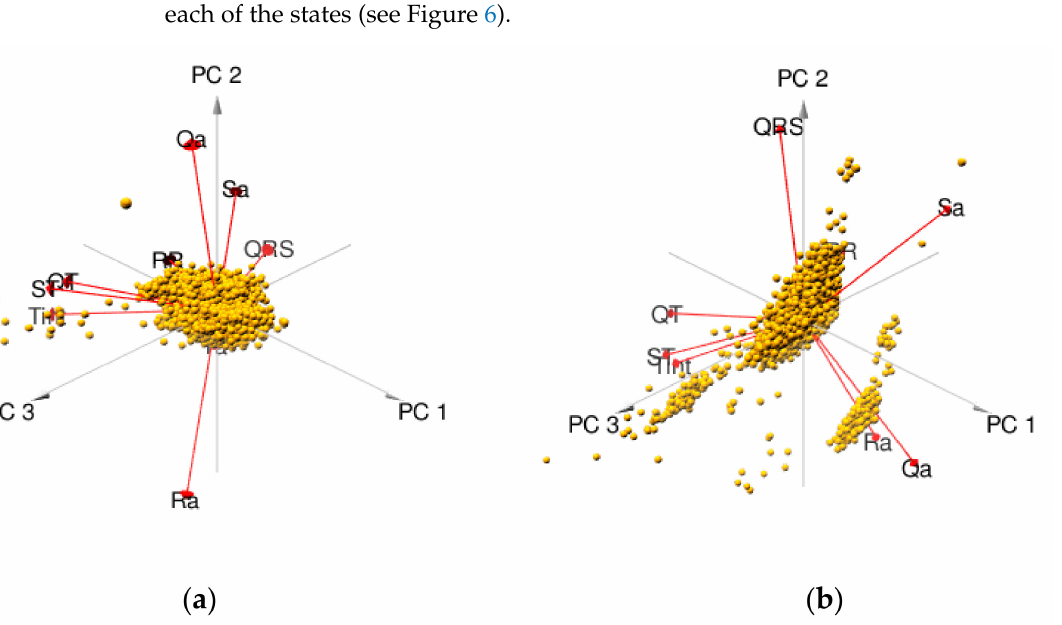
Figure 6. 3D plots of the PCA performed on factorial data: ( a ) morning; ( b )